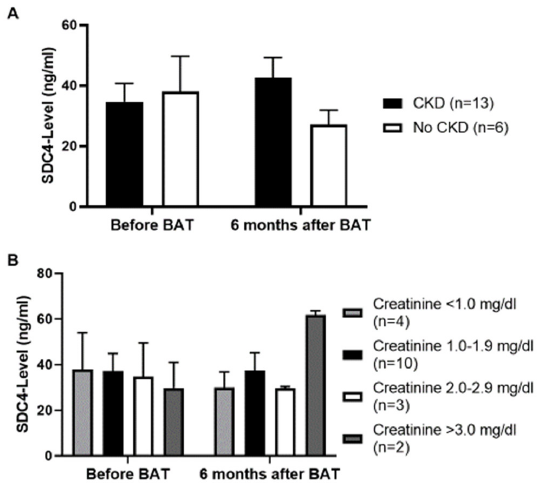
are given as means ±